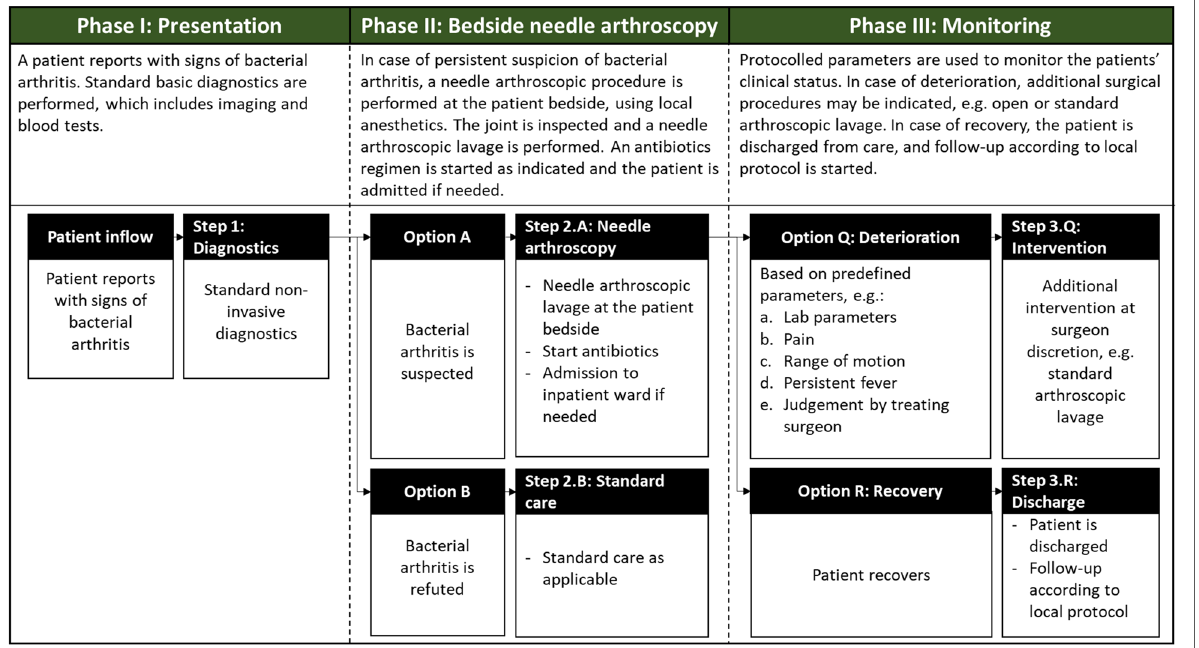
Fig. 2 Needle arthroscopy can successfully be used as the initial intervention in suspected bacterial arthritis of a native joint. Incorporating needle arthroscopy in the management protocol may result in less use of surgical interventions as standard arthroscopy or open surgery, whilst standard surgery can always be deployed as a back-up intervention for non-improving